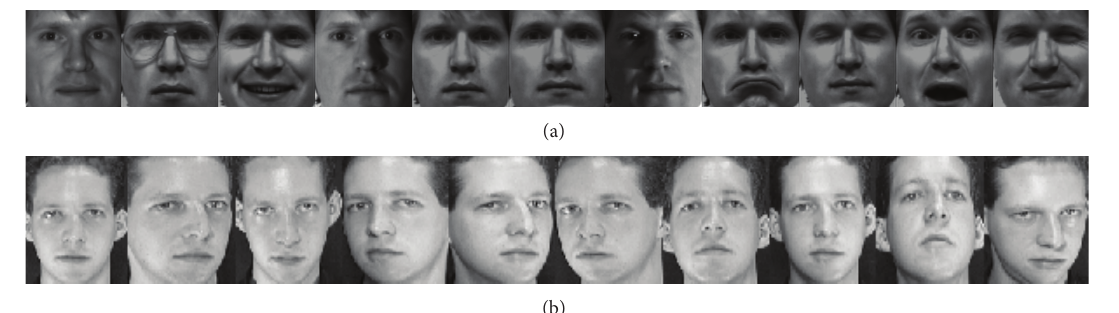
Figure 3: Face sample images of one person. (a) Yale, (b)